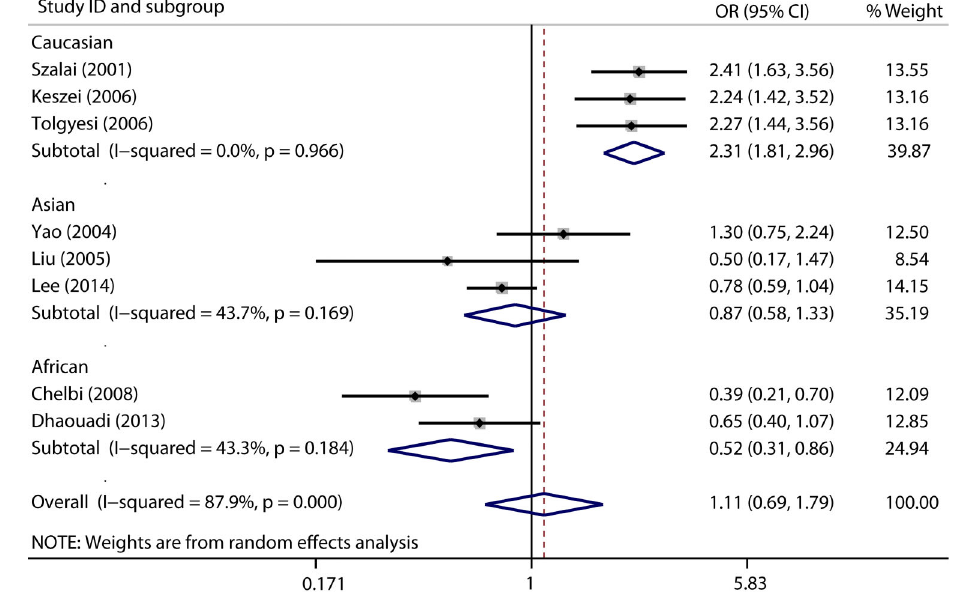
Figure 2. Forest plots of the association between the MCP-1 -2518 A 4 G polymorphism and risk of asthma in the dominant